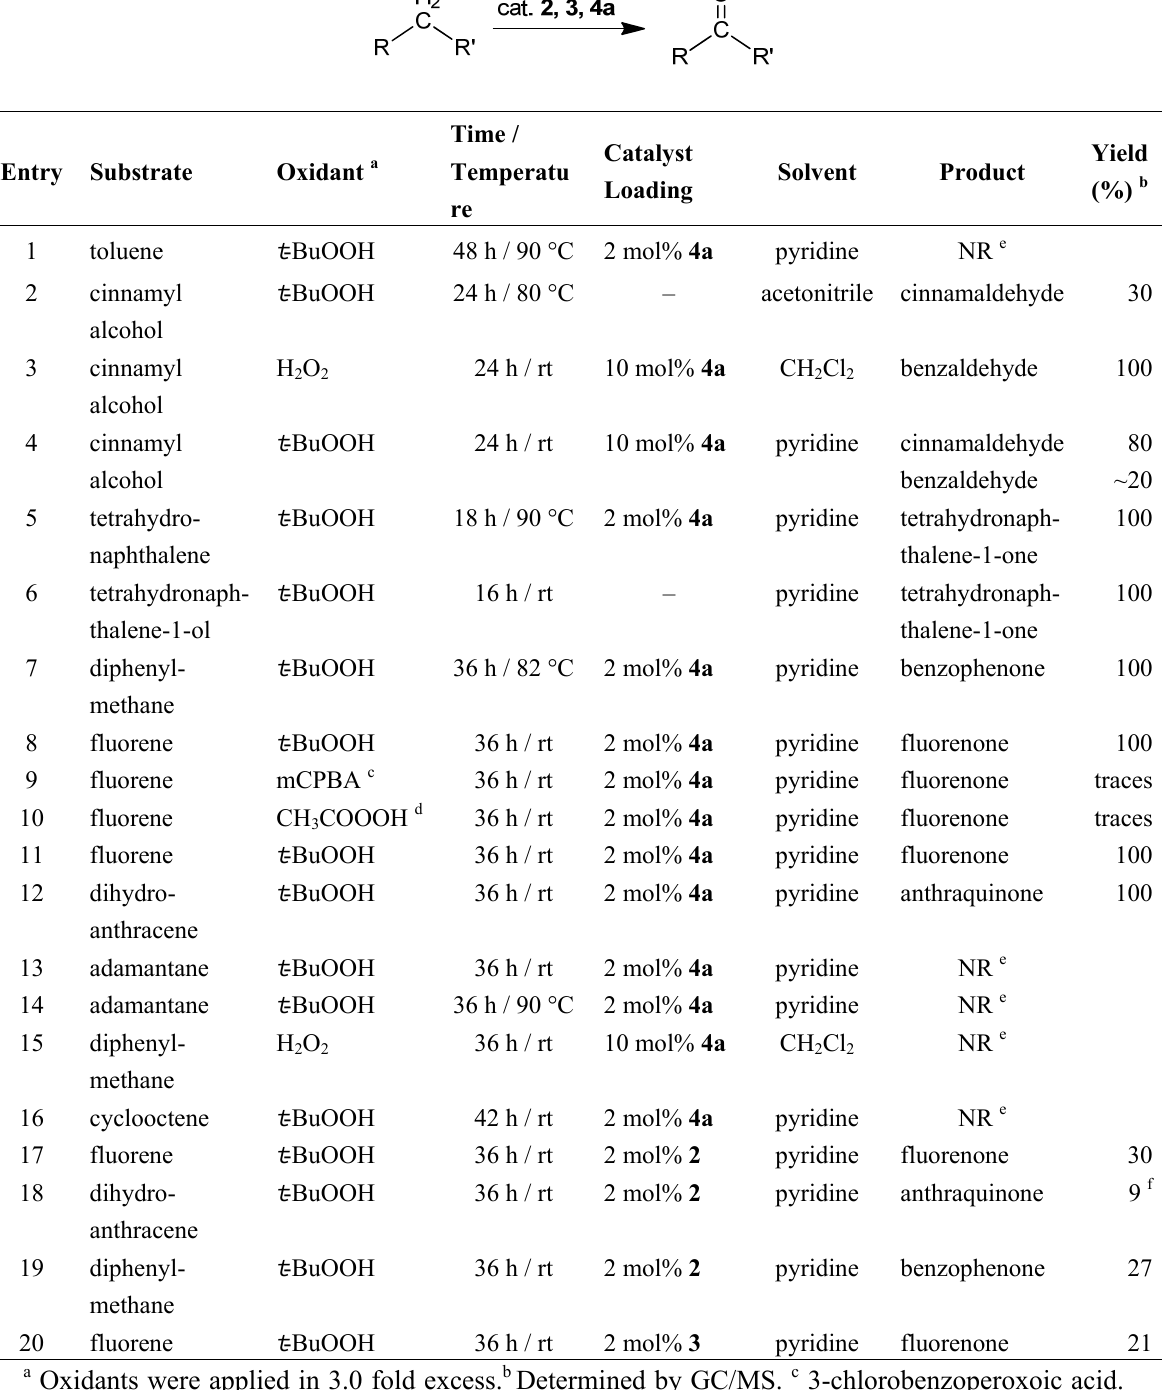
Table 3. Screening of catalyst